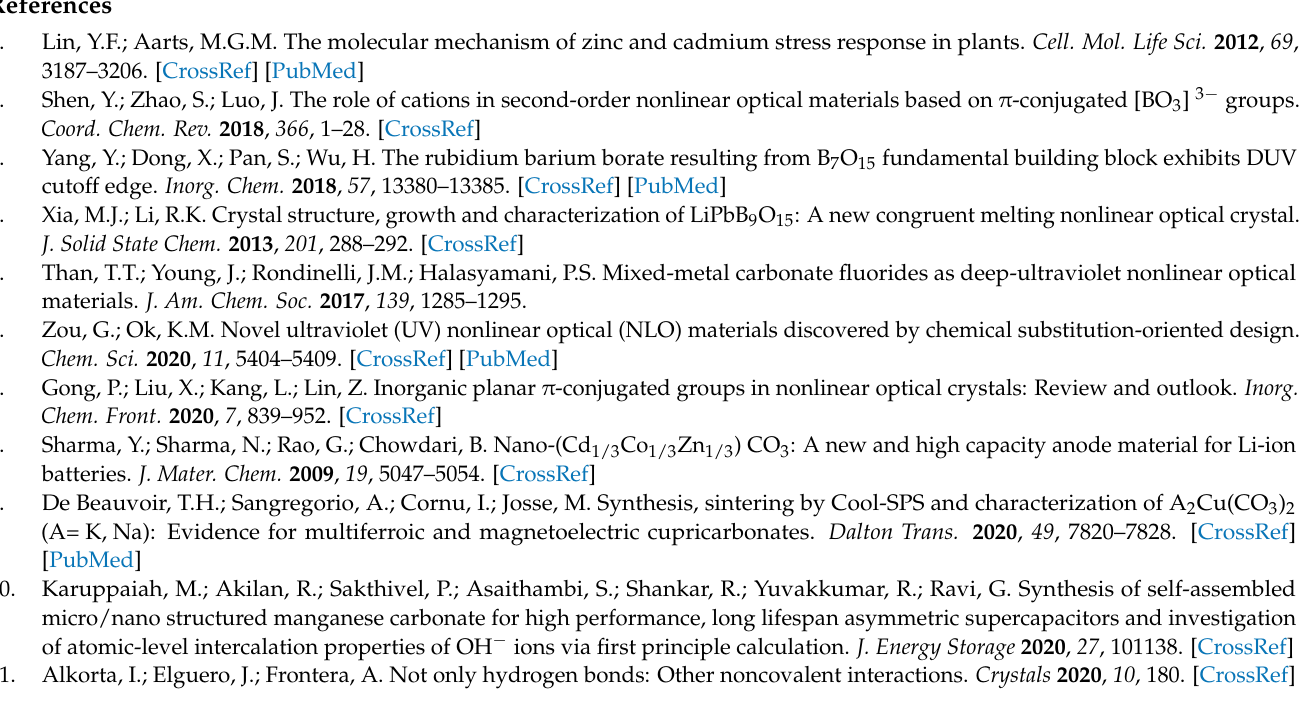
Supplementary Materials: The following are available online. Table S1 Angles ( α , deg) and binding distances (R, Å) in the ternary complexes as well as their difference ( ∆ ) relative to the binary analogues. Table S2 Electron densities ( ρ , au) at the intermolecular BCPs in the ternary systems and their change ( ∆ ρ , au) relative to the binary analogues. Table S3 Laplacians ( ∇ 2 ρ ) and energy densities (H) at the intermolecular Se ··· O and M ··· N BCPs in the ternary complexes, all in au. Table S4 The most negative MEP (V S,min ) on the O atom of C=O bond in the spodium-bonded binary complex and the most positive MEP (V S,max ) on the M atom in the chalcogen-bonded binary complex as well as their difference ( ∆ V) relative to the corresponding monomers, all in kcal/mol. Table S5 Charge transfer (CT, e) of chalcogen and spodium bonds in the ternary complexes and its change ( ∆ CT, e) relative to the binary analogues. Figure S1 Relationship between both angles of Se-H · · · O ( α 2) and X-Se · · · O ( α 1). Figure S2 Non-covalent interaction (NCI) maps of the chalcogen-bonded dyads. Blue, green, and red areas correspond to strong attractive, weak attractive and strong repulsion interactions, respectively. Figure S3 Interaction energy ( ∆ E) versus second-order perturbation energy (E(2)) of LpO → σ *Se-X orbital interaction in the chalcogen-bonded dyads. Figure S4 Interaction energy ( ∆ E) versus a) electrostatic energy (Ees), b) polarization energy (Epol), and c) dispersion energy (Edisp) in the chalcogen-bonded dyads. Figure S5 MEP maps on the 0.001 electrons Bohr − 3 isodensity surface of monomers. Red and blue regions represent positive and negative MEPs, respectively. All are in